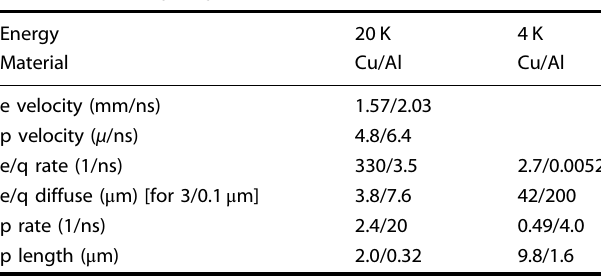
Table 3. Scattering lengths.